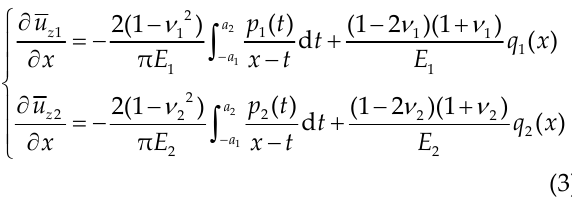
and E and ν and ν are the 1 2 1 2 and a ( a > 0, a > 0) 1 2 1 2